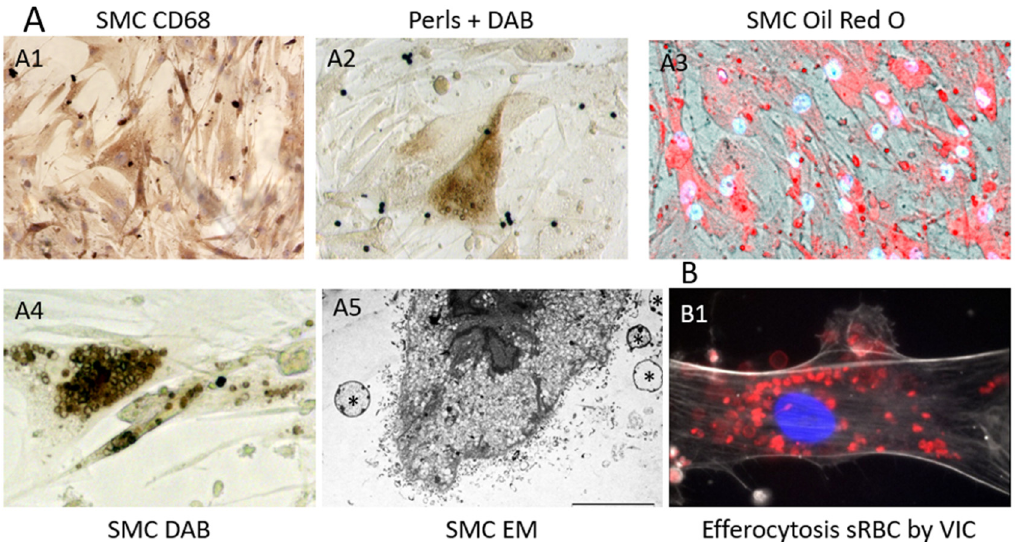
Figure 3. Phagocytosis of senescent RBCs by cultured human SMCs: ( A ) SMCs exposed to senescent sRBCs (( A1 ) acquisition of CD68, the phagolysosome functional marker of phagocytosis activity by cultured SMCs, usually used as a marker of macrophages, but not lineage-specific; ( A2 ) acquisition of intracellular Fe ++ staining; ( A3 ) acquisition of lipid staining from sRBC membranes within SMCs; ( A4 ) early phagocytosis of intact sRBCs, stained by DAB alone (pseudo-peroxidase activity); and ( A5 ) electron microscopic view of efferocytosis of sRBCs by cultured human SMCs with the presence of extracellular RBC skeletons (*), containing hyperdense bodies, potentially iron and extracellular release of numerous micro-vesicles and exosomes by the sRBC-phagocytic SMCs); and ( B ) valvular Interstitial Cell (VIC) (( B1 ) efferocytosis of sRBCs (red) by human VIC).